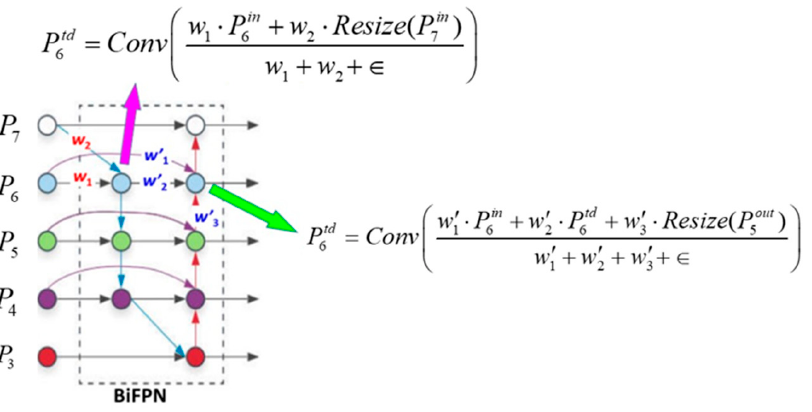
Figure 6. BiFPN feature fusion process.